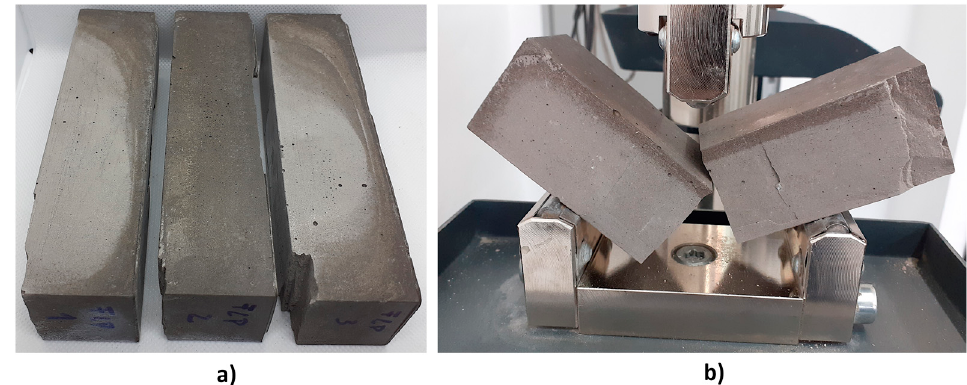
Figure 4. Samples made of mixture FBC FA + M (25%) demolded after 7 days; picture taken after 28 days of curing ( a ) before the strength tests; ( b ) during the three-point bending test.